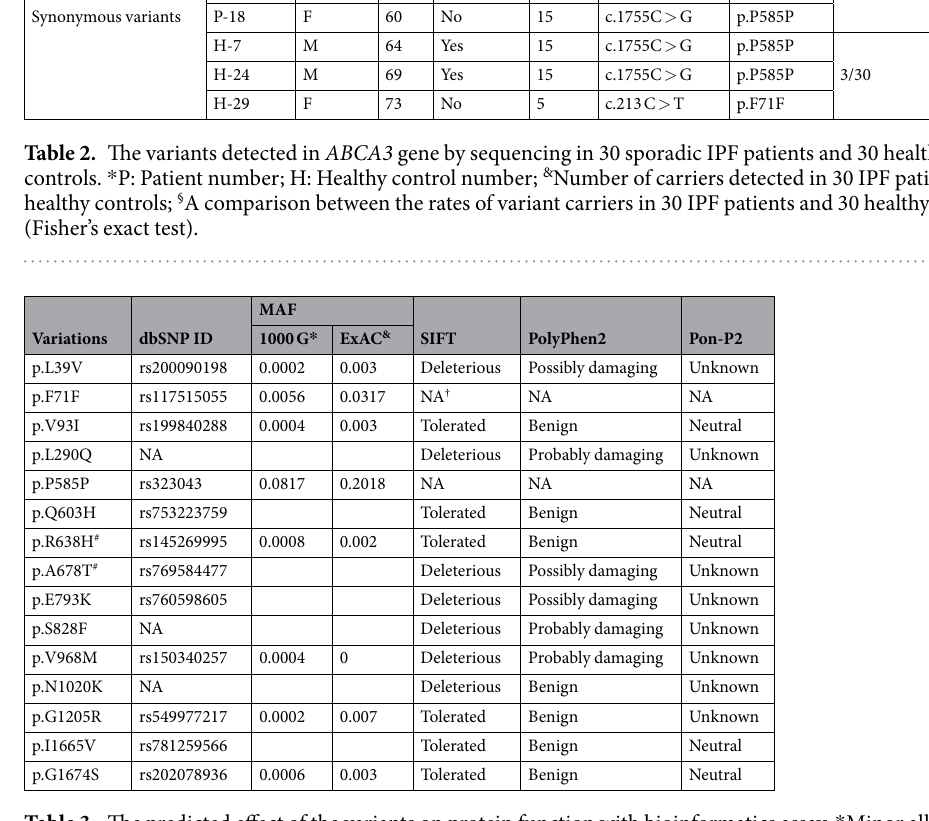
Table 3. The predicted effect of the variants on protein function with bioinformatics assay. * Minor allele frequency (MAF) from 1000 Genomes Project (1000 G); & MAF from Exome Aggregation Consortium (ExAC) in East Asians; † NA: not available; # The two variants were detected in the healthy